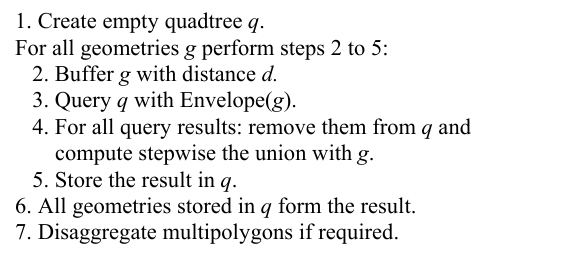
Figure 16. Algorithm 5 for buffering and merging sets of